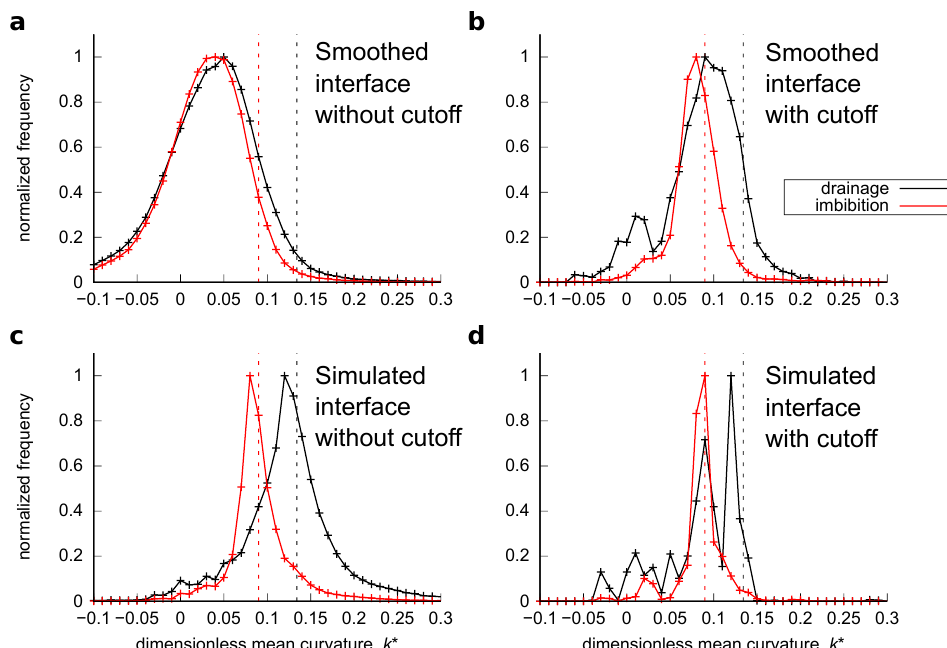
Figure 14. Histograms of the computed curvatures for the Bentheimer sandstone. ( a ) Interfacial curvature computed on the smoothed interface after drainage and imbibition without the distance cutoff and ( b ) with the distance cutoff. ( c ) Interfacial curvature computed on the simulated interface after the drainage and imbibition without the distance cutoff and ( d ) with the distance